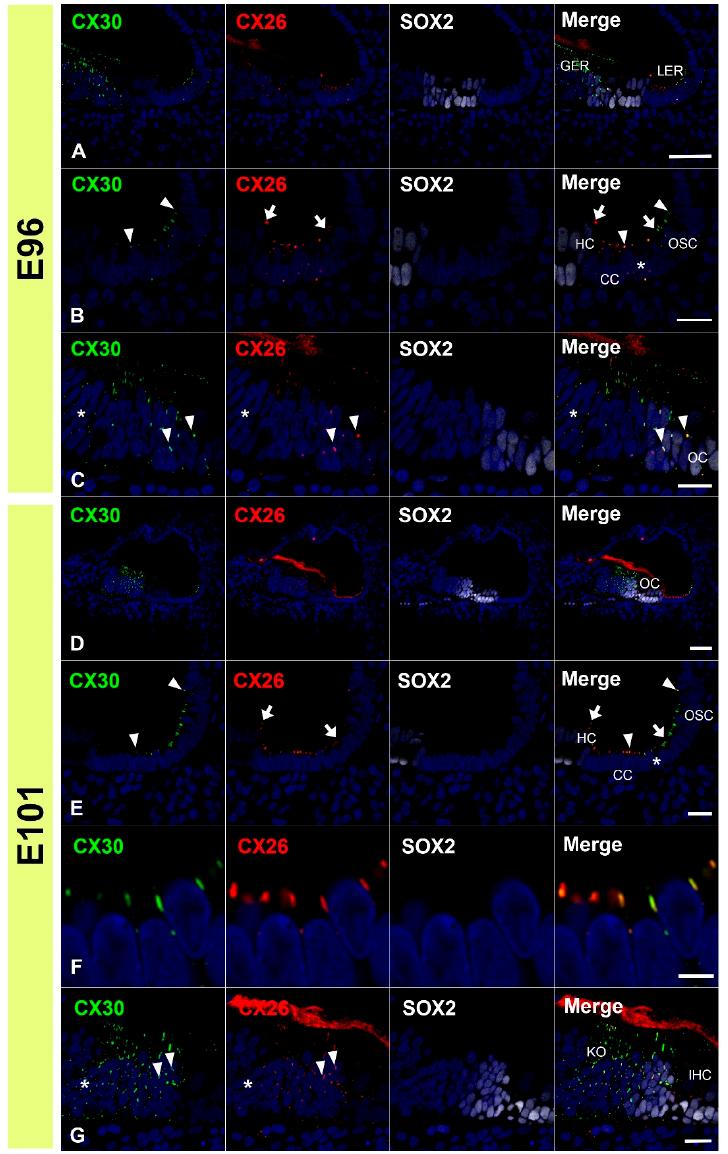
Figure 5. Comparison of the expression patterns of CX26 and CX30 at E96 and E101. ( A – C ) At E96, a partial overlap in expression of CX26 and CX30 was observed. In the LER, CX26 expression was detected more on the modiolus side (between arrows in ( B )), while CX30 expression was detected more laterally (between arrowheads in ( B )). Overlapping expression was observed in a part of immature Claudius’ and outer sulcus cells (asterisk in ( B )). In the GER, partial overlap in expression was observed on the lateral side (arrowheads in ( C )). On the modiolus side, only CX30 expression was detected (asterisk in ( C )). ( D – G ) At E101, partial overlap in the expression of CX26 and CX30 was also observed, as seen at E96. In the LER, CX26 expression was detected more on the modiolus side (between arrows in ( E )), while CX30 expression was detected more laterally (between arrow- heads in ( E )). Overlaps in expression were observed in some immature Claudius and outer sulcus